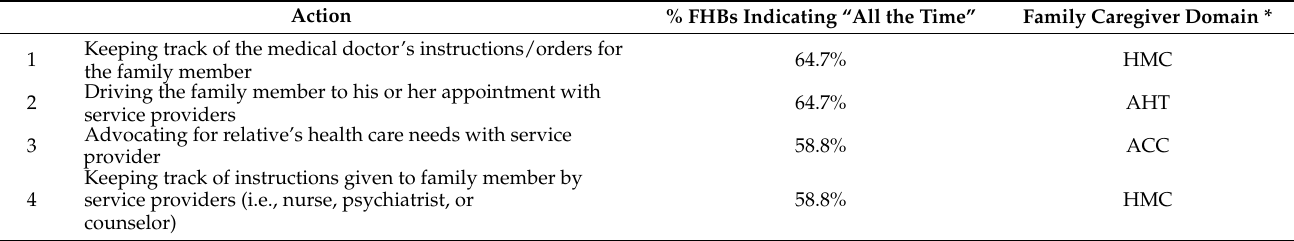
Table 2. Percentage of FHBs indicating actions performed “all the time” on behalf of their family